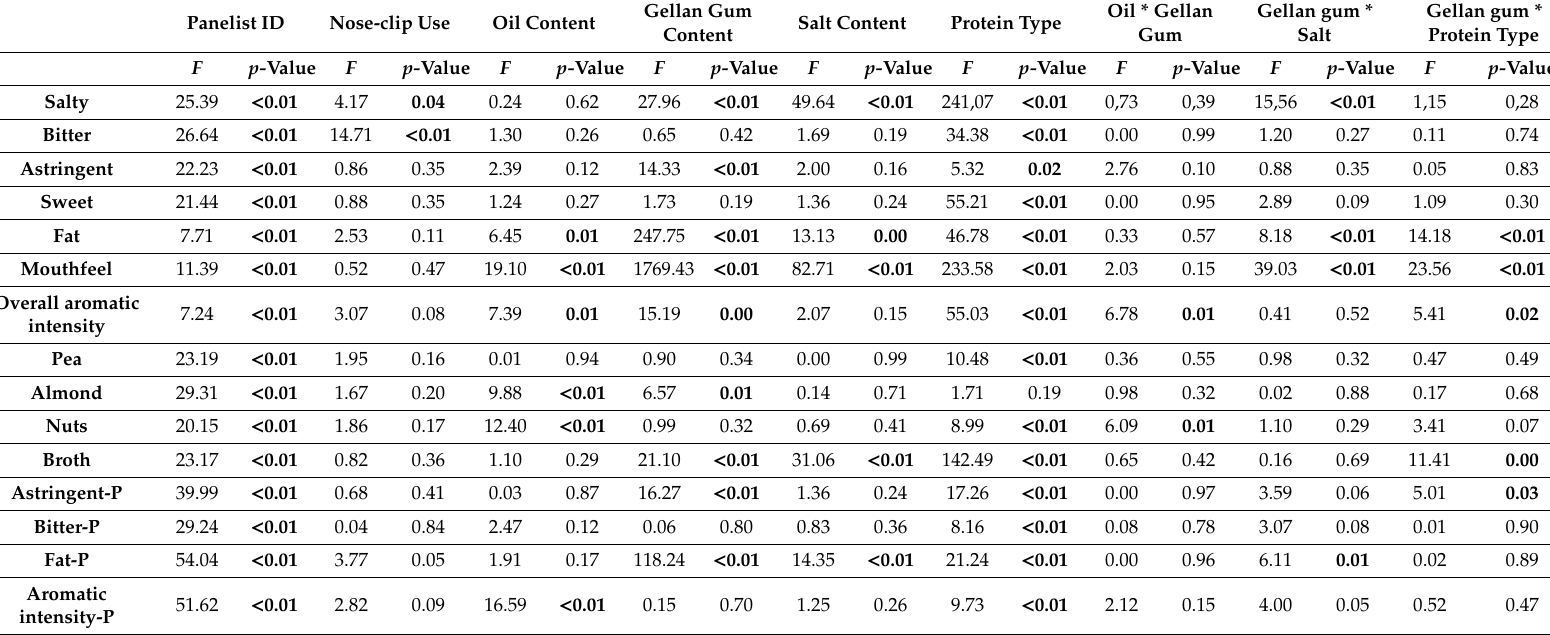
Table 4. Results of the five-way ANOVAs (panelist ID, nose-clip use, oil content, gellan gum content, salt content, and protein type as fixed e ff ects + their first-order interactions) examining the e ff ects of beverage composition on attribute perception using the static block profiling data (total degrees of freedom: 739; residual degrees of freedom: 716). Significant p -values are in bold ( α = 0.05). Abbreviations: Astringent-P = persistence of astringency; Bitter-P = persistence of bitterness; Fat-P = persistence of fattiness; and Aromatic intensity-P = persistence of overall aromatic